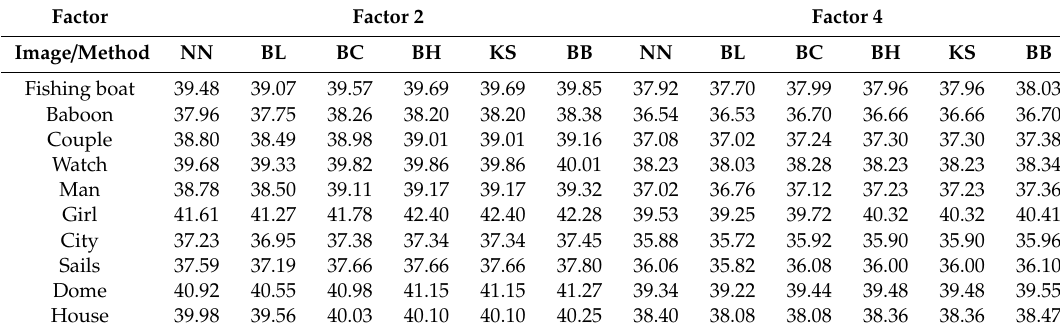
Table 8. Comparison results in terms of